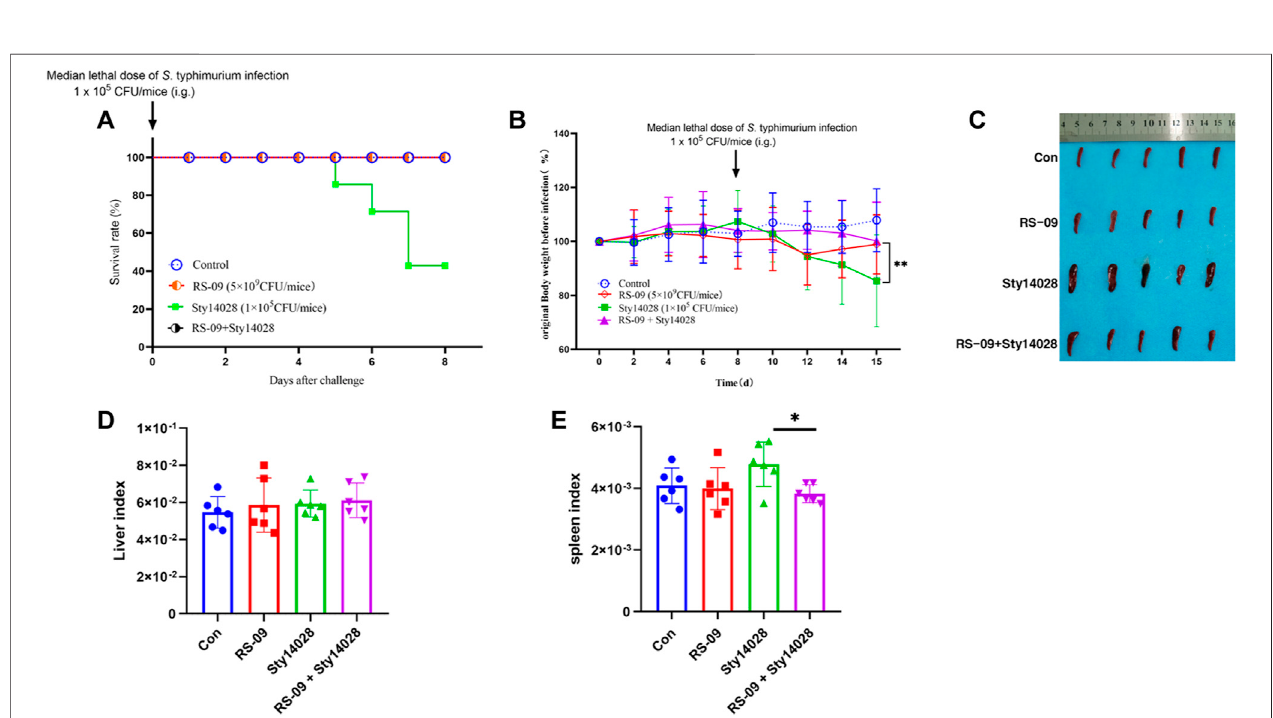
FIGURE 2 | Pretreatment with RS-09 protects mice from S . Typhimurium infection. (A) Survival rates of mice following RS-09 pretreatment and challenge with pathogenic S . Typhimurium. RS-09 was administered to mice for 7 days, and they were then orally injected with a sublethal dose of Sty14028 suspension (10 5 CFU/ mouse). The survival of mice was recorded daily. (B) Comparison of body weight loss (current body weight/original body weight before infection) over 8 days post- infectiondaily. (C) RS-09relievedSty14028-induced splenomegaly(thescaleisshown inthediagram). (D) Theliverweightindex(liverweight/bodyweight) (E) The splenic weight index (spleen weight/body weight). Data are the means ± SD ( n = 6). * p <